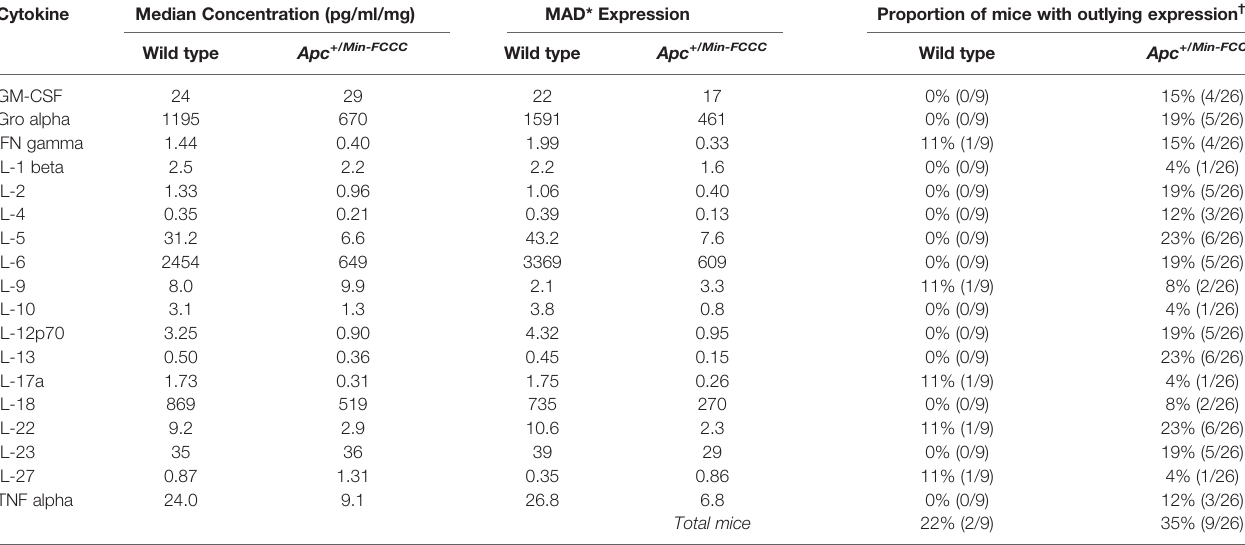
TABLE 3 | Intra-group variability in secretion of cytokines involved in Th1, Th2, Th9, and Th17 signaling from initiated colon tissues from Apc +/Min-FCCC mice vs normal colon tissues from wild type mice. Cytokine Median Concentration (pg/ml/mg) MAD* Expression Proportion of mice with outlying expression